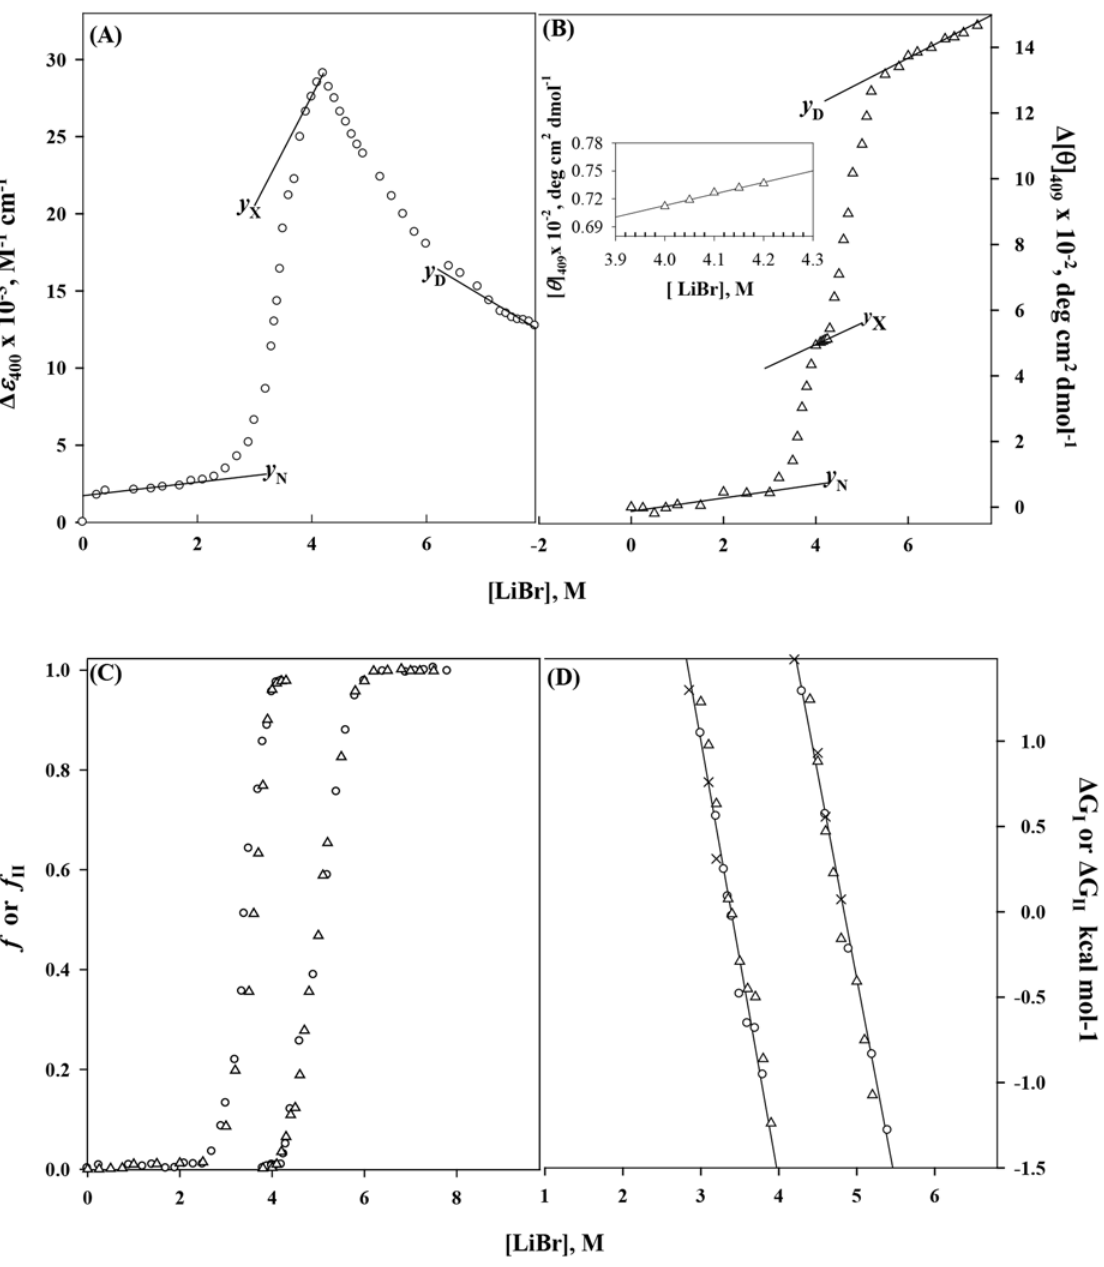
Fig 1. LiBr-induced denaturation of cyt- c at pH 6.0 and 25°C. Equilibrium unfolding transition curves are monitored by Δ ε 400 (A) and Δ [ θ ] 409 (B). Panels (C) and (D) show the normalized transition curves and plots of Δ G I and Δ G II as function of [LiBr], respectively. The inset in panel (B) shows the plot for the dependence of the optical property of X state ( y X ) on [LiBr] on the expanded scale. Filled symbol in panel (D) represents Δ G I (or Δ G II ) determined from heat- induced denaturation in the presence of a given [LiBr].